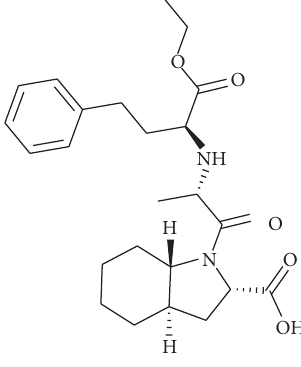
Figure 1: Structure of